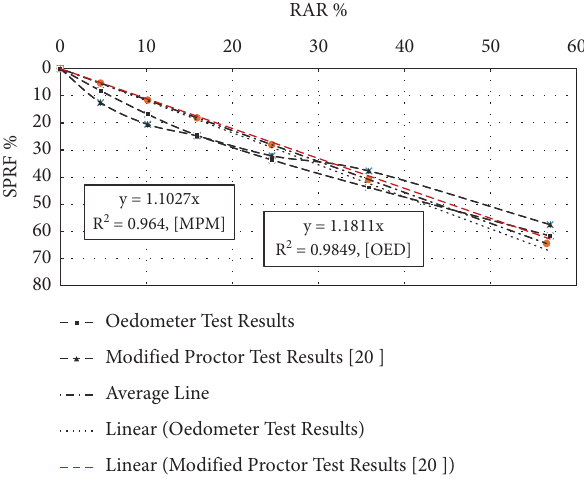
Figure 5: Variations of SPRF with RAR for both OED and MPM. Table 6: Comparison of SPRF (%) obtained from equation (6) with that from Herg¨ul [51]. Experimental values obtained by [50] Predicted values from equation (6) RAR (%)